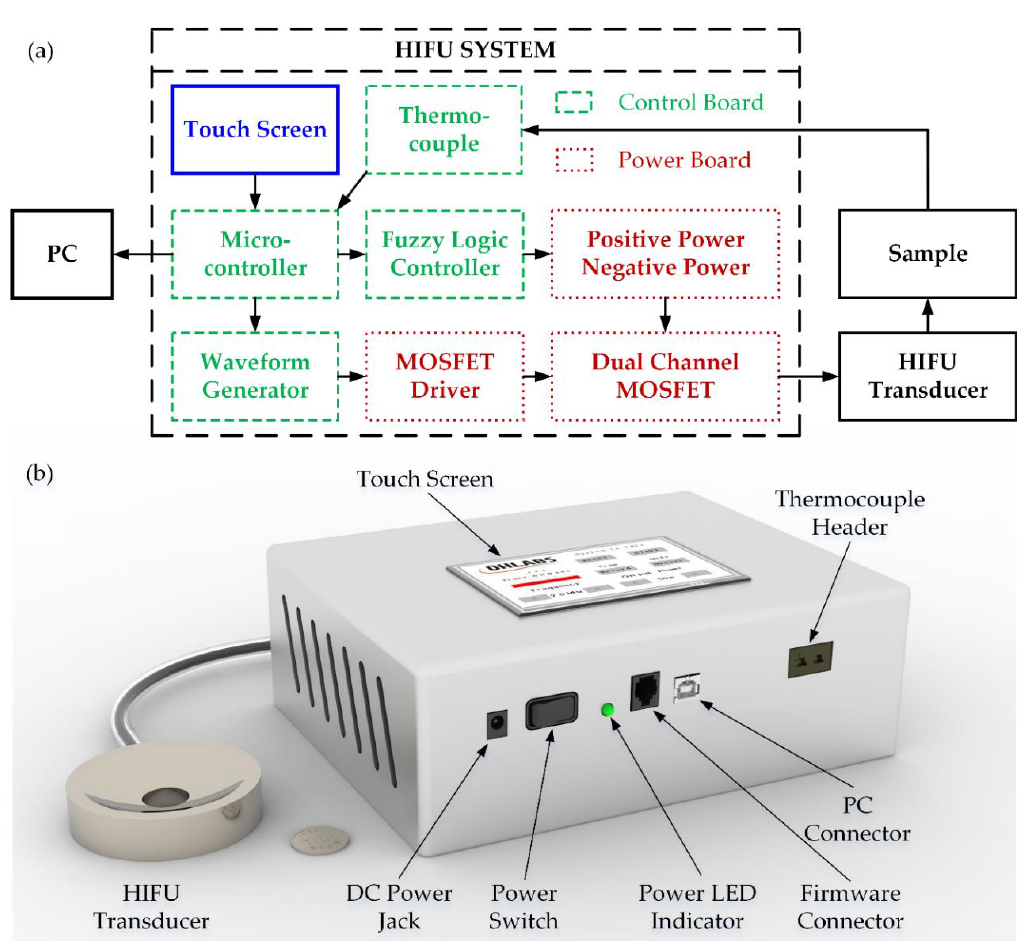
Figure 1. HIFU system: ( a ) schematic diagram ( b ) 3D design.